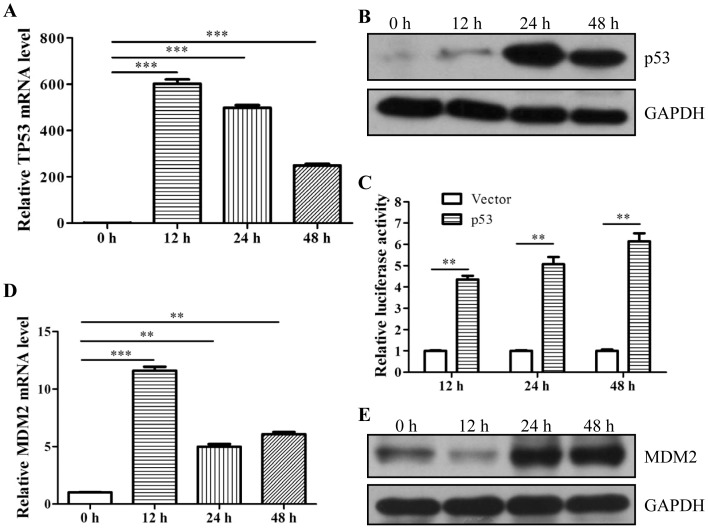

TP53 overexpression in HNE2 cells.HNE2 cells were transfected with a TP53 expression vector (the pCMV-p53 plasmid). Levels of (A) TP53 mRNA transcripts and (B) p53 protein expression were determined at 0–48 h post-transfection by qRT-PCR and western blotting, respectively. (C) To measure p53 transcriptional activity, the pCMV-p53 and the pp53-TA-luc plasmids were cotransfected into HNE2 cells, and transcriptional activity of p53 from 0–48 h post-transfection was determined by luciferase assays. Similarly, induction of (D) MDM2 mRNA transcripts and (E) MDM2 protein expression in HNE2 were also determined in HNE2 pCMV-p53 transfectants by qRT-PCR and western blotting. GAPDH protein expression was detected as a loading control for p53 and MDM2 western blots. Data shown are representative of 3 independent experiments. Bar graphs show mean ± S.D. **P<0.01, ***P<0.001.